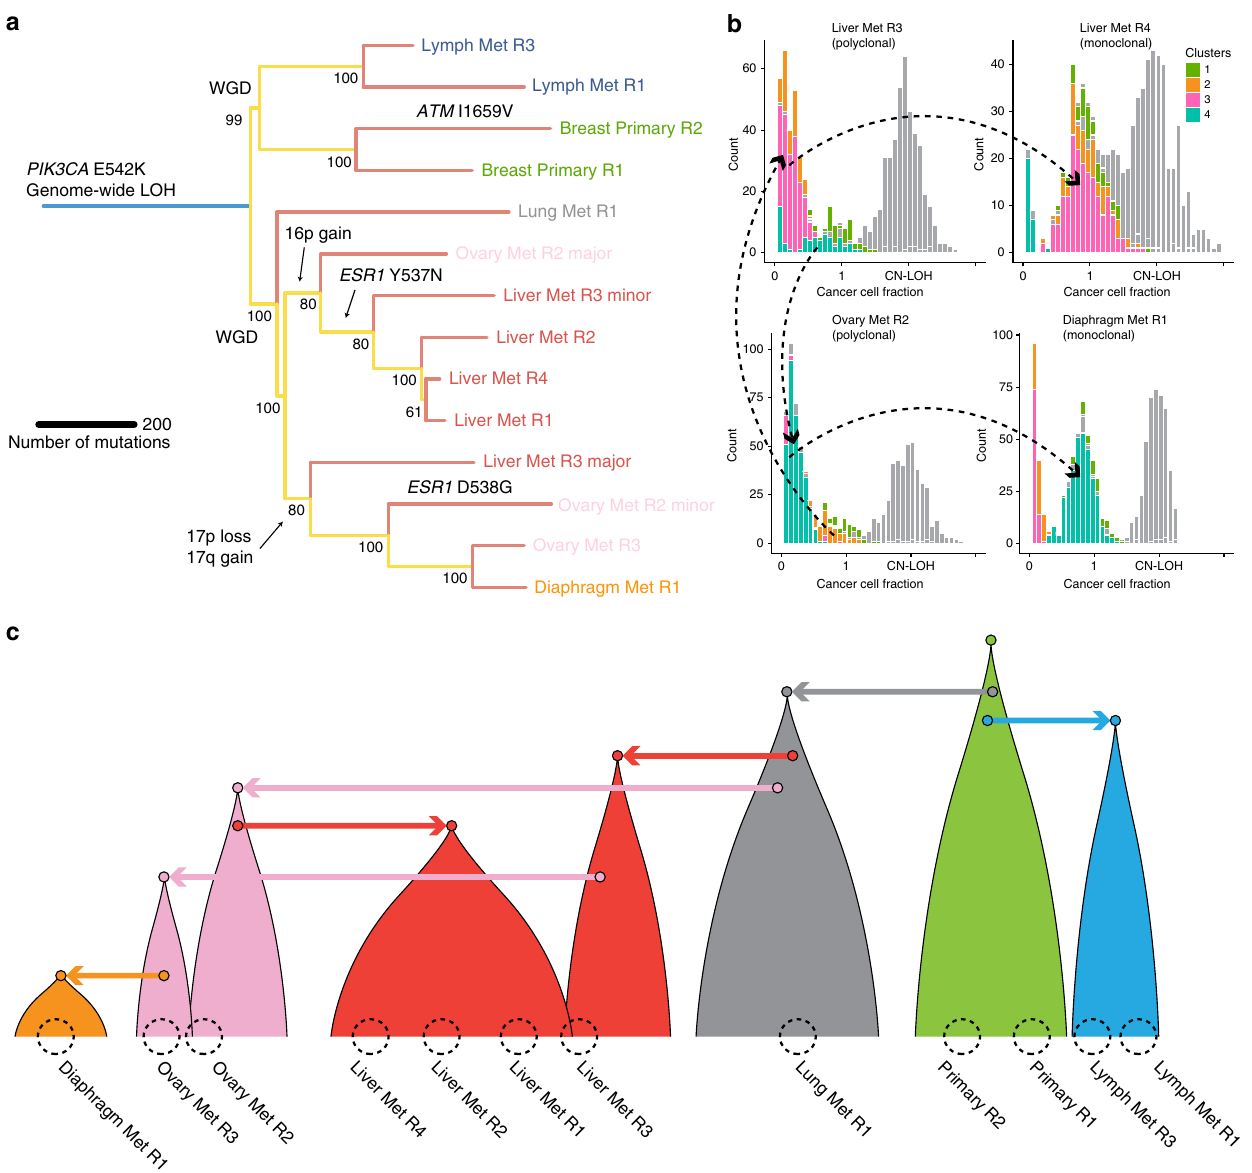
Fig. 2 Clonal evolution analysis of LEGACY patient 1. a Subclonal decomposition allows construction of the tumour clone tree from the sample tree, thus revealing the evolutionary history of the metastatic cascade. b Only 2/12 samples were found to be polyclonal (Liver Met R3 and Ovary Met R2) and indeed exchanged clones between each other. The same clones went on to seed distinct metastatic deposits in a monoclonal fashion. For example, the pink subclone in Liver Met R3 appears clonal in Liver Met R4. The turquoise subclone in Ovary Met R2 appears clonal in Diaphragm Met R1. The two clones remain subclonal but at distinct proportions in the two polyclonal samples Liver Met R3 and Ovary Met R2. Other clones are greyed for clarity. c Reconstructed metastatic cascade in breast cancer LEGACY patient 1 shows that the primary tumour (green) spread early to the lung (grey) and subsequently spread independently to draining lymph nodes (blue). From the lung, the cancer spread to Liver Met R3 (red) and Ovary Met R2 (pink) in two independent waves. Liver Met R3 then spread to Ovary Met R3 and subsequently to diaphragm (orange). Ovary Met R2 independently re-seeded back to the liver, giving rise to a large clone (Liver Met R1, R2, and R4). Hence, polyclonal seeding was evident in one liver and one ovary sample, but otherwise early monoclonal seeding was the dominant pattern of metastatic alterations such as chromosome 1q gain and 16q loss (Supple- ● Months 50 – 53: Seventh-line therapy with CDK4/6 inhibitor palbocliclib and exemestane (previously intolerant to fulves- mentary Data 1). A chromosome 8 gain was unique to Liver Met trant) R3 (Fig. 3b). Mutational analysis reveals a clonal PIK3CA G1049R ● Month 53: Died (fulminant hepatic failure) and a clonal ERBB2 E770_A771insAYVM mutation (Fig. 3c, Supplementary Data 2). Chromosome 13 loss was identi fi ed in all Whole-genome at median 95× depth (73 – 119×) was performed samples. The heterozygous loss contains BRCA2 and RB1, the in nine samples from the para-aortic lymph nodes, lung and liver, latter linked to resistance to CDK4/6 inhibitors 28 . Interestingly, in addition to normal DNA (blood) as previously (39×, Fig. 3a). the two samples with the highest number of private mutations Copy number alterations were largely homogeneous across metastatic sites and include common breast cancer copy number were Liver Met R2 and R3, both of which had distinct truncating